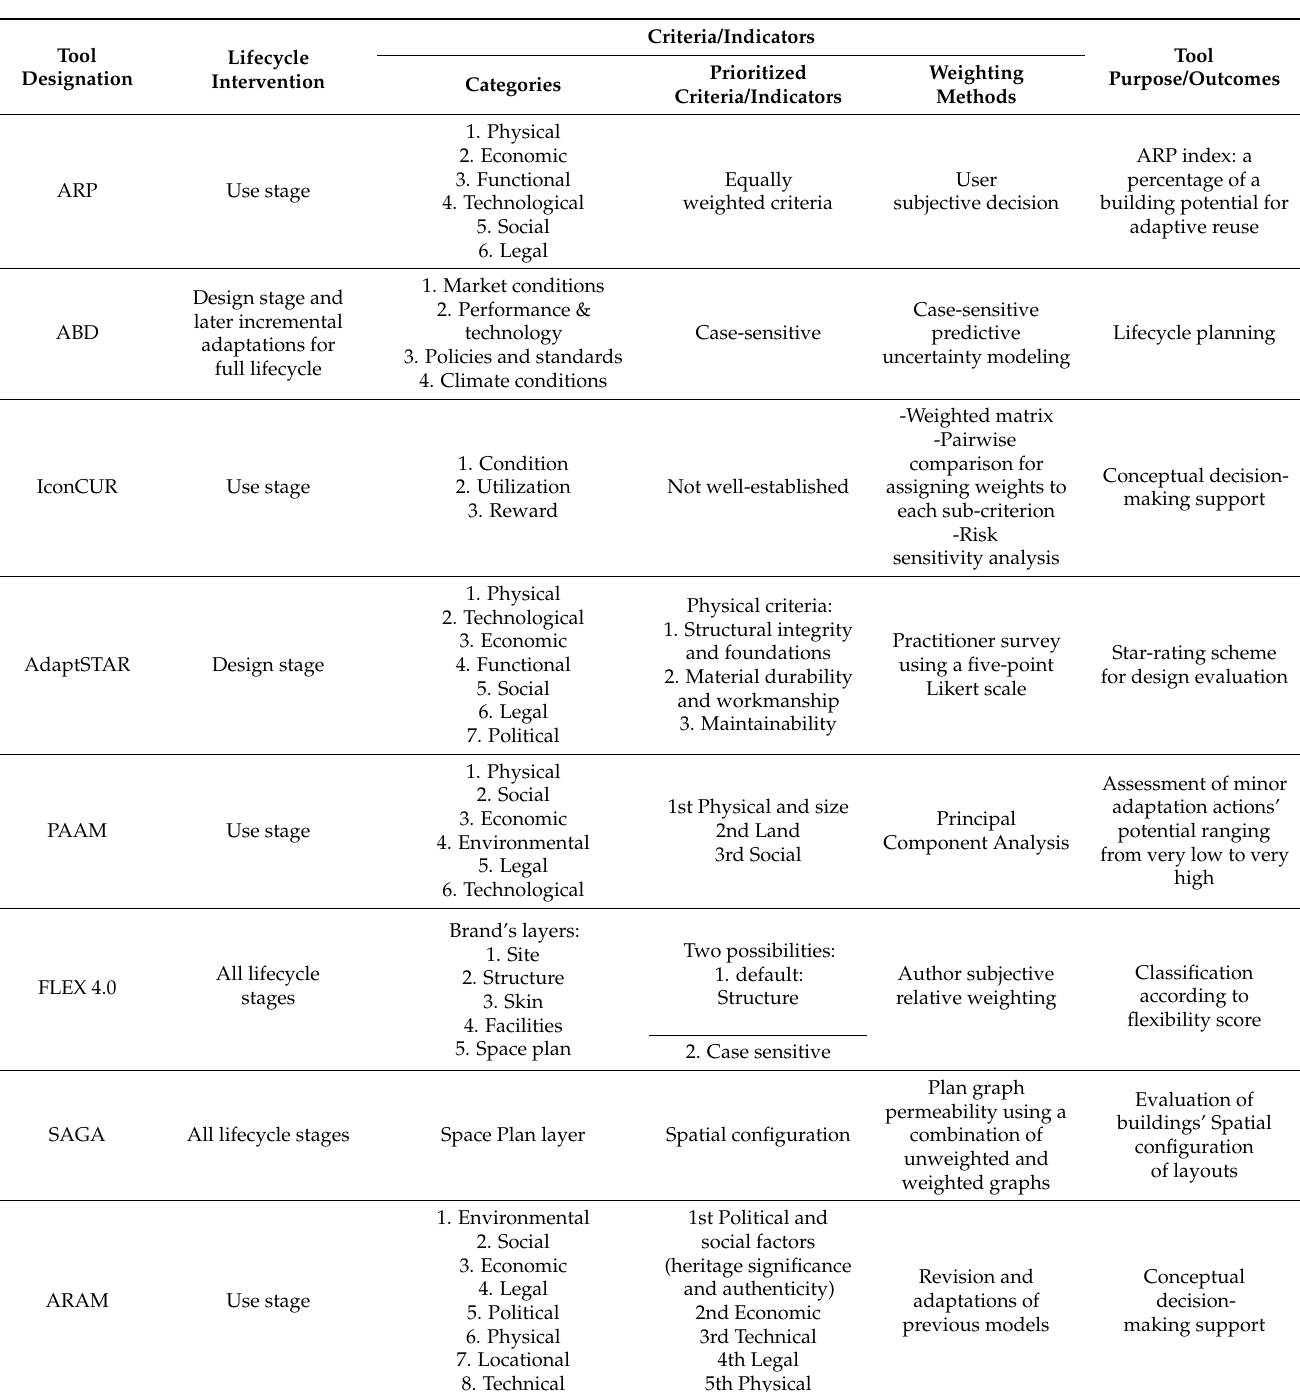
Table 1. Comparative analysis of existing adaptability models and tools (lifecycle intervention, indicators and